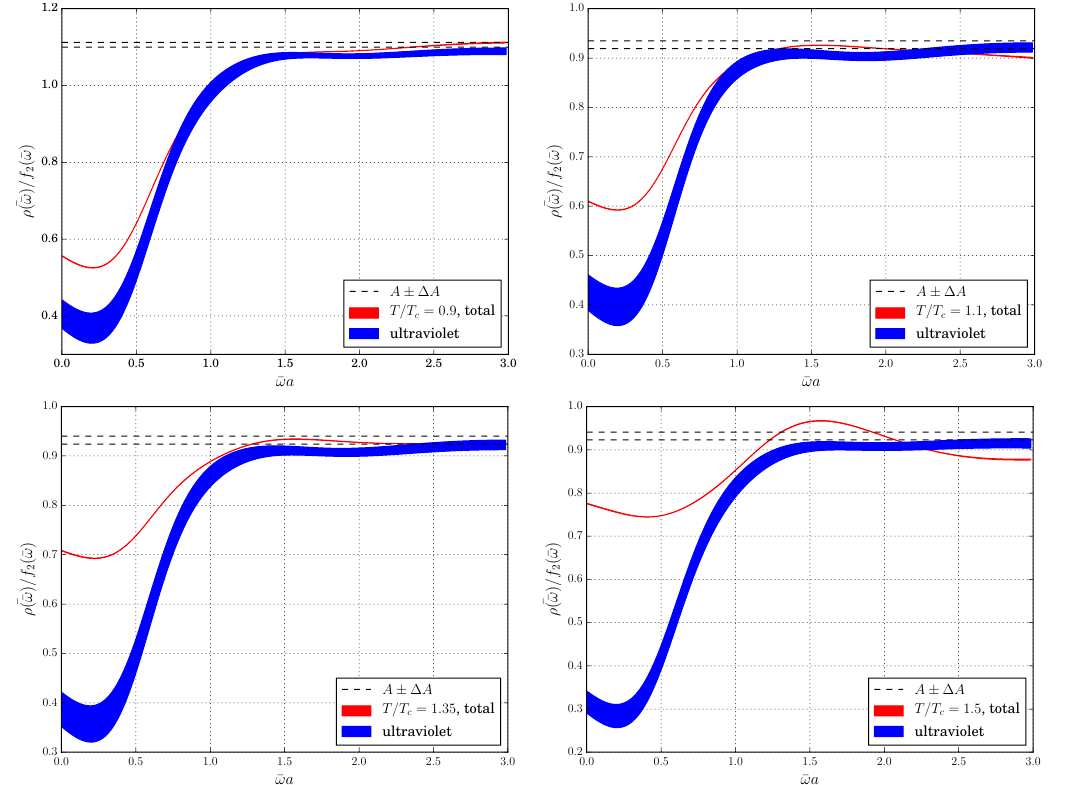
Figure 3 . The ratios (cid:22) (cid:26) ((cid:22) ! ) =f 2 ((cid:22) ! ) as a function of (cid:22) !a for the temperatures T=T c = 0 : 9 ; 1 : 1 ; 1 : 35 ; 1 : 5. Red curves correspond to the spectral functions restored by the BG method from the data. Blue curves correspond to the ultraviolet contribution in form (3.14) convoluted with the resolution function. Dashed lines are values of the constants A with uncertainties obtained within the (cid:12)tting